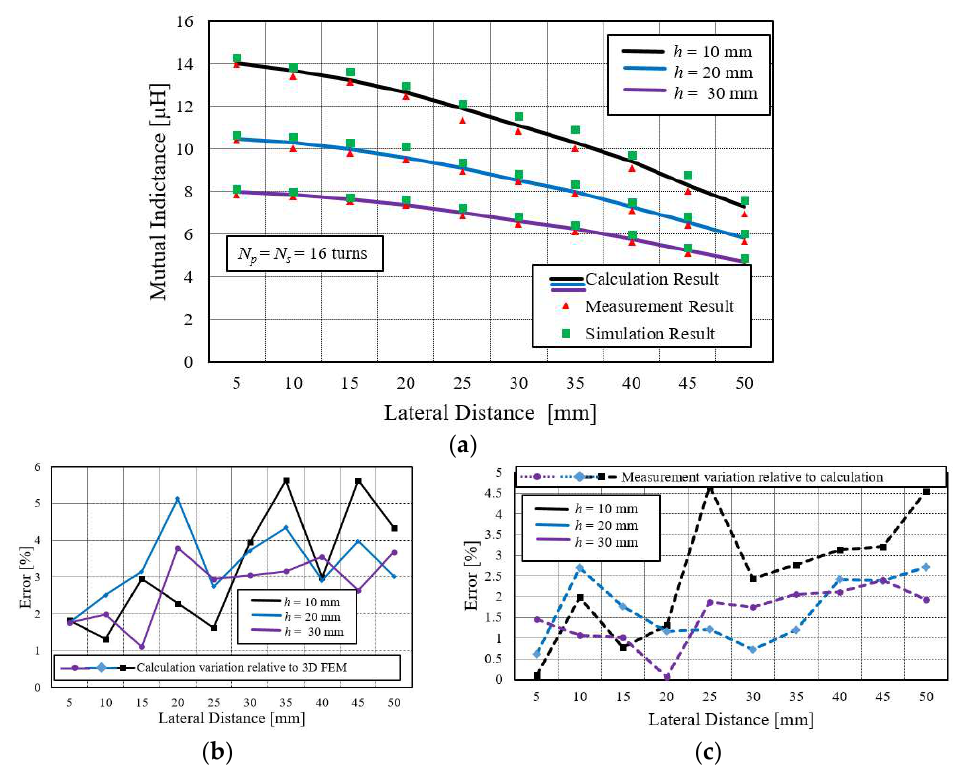
Figure 6. ( a ) Mutual inductance comparison between large primary and large secondary coils at various lateral misalignment distances. ( b ) Calculation variation relative to simulation (FEM) for N = 16. ( c ) Measurement variation relative to calculation.